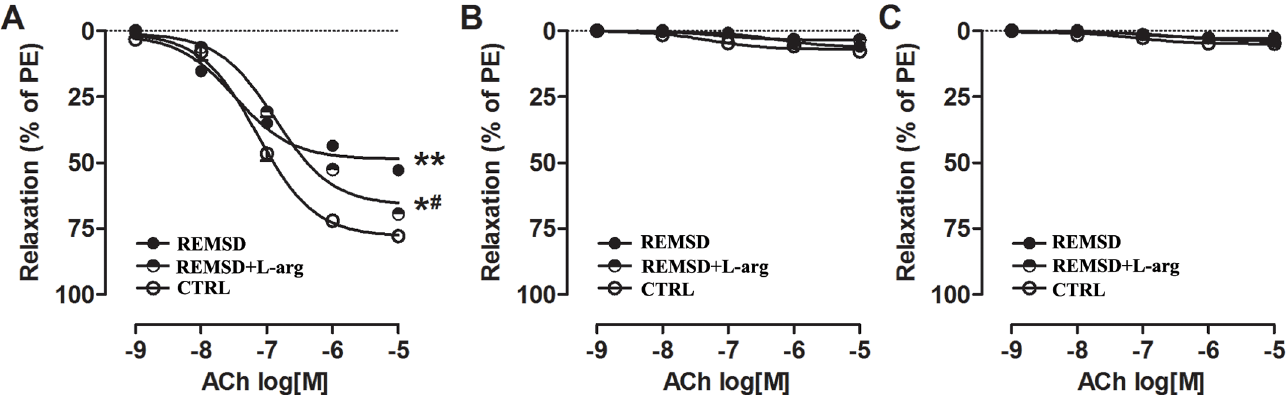
Fig 3. Different channel mediated vasorelaxation of the aortas of middle-aged rats. (A)NO-mediated vasorelaxation.NO-mediatedrelaxation was determinedin the presenceof 10 μ M indomethacin and 1 μ M TEA to block PGI 2 and EDHF, respectively. (B)PGI 2 -mediatedvasorelaxation.PGI 2 - mediated relaxation was evaluatedwith 100 μ M L-NAME and 1 μ M TEA to block NO and EDHF, respectively.(C)EDHF-mediatedvasorelaxation. EDHF-mediated relaxationwas determined in the presence of 100 μ M L-NAME and 10 μ M indomethacin to block NO and PGI 2 , respectively.Each point representsa mean ± SEM;n = 6 rats per study group. * E max significantly different from that of CTRL ( * P < 0.05). # E max significantly different from that of REMSD ( # P < 0.05).CTRL, control rats without REM sleep deprivation; REMSD, REM sleep deprivation;L-arg, L-arginine.